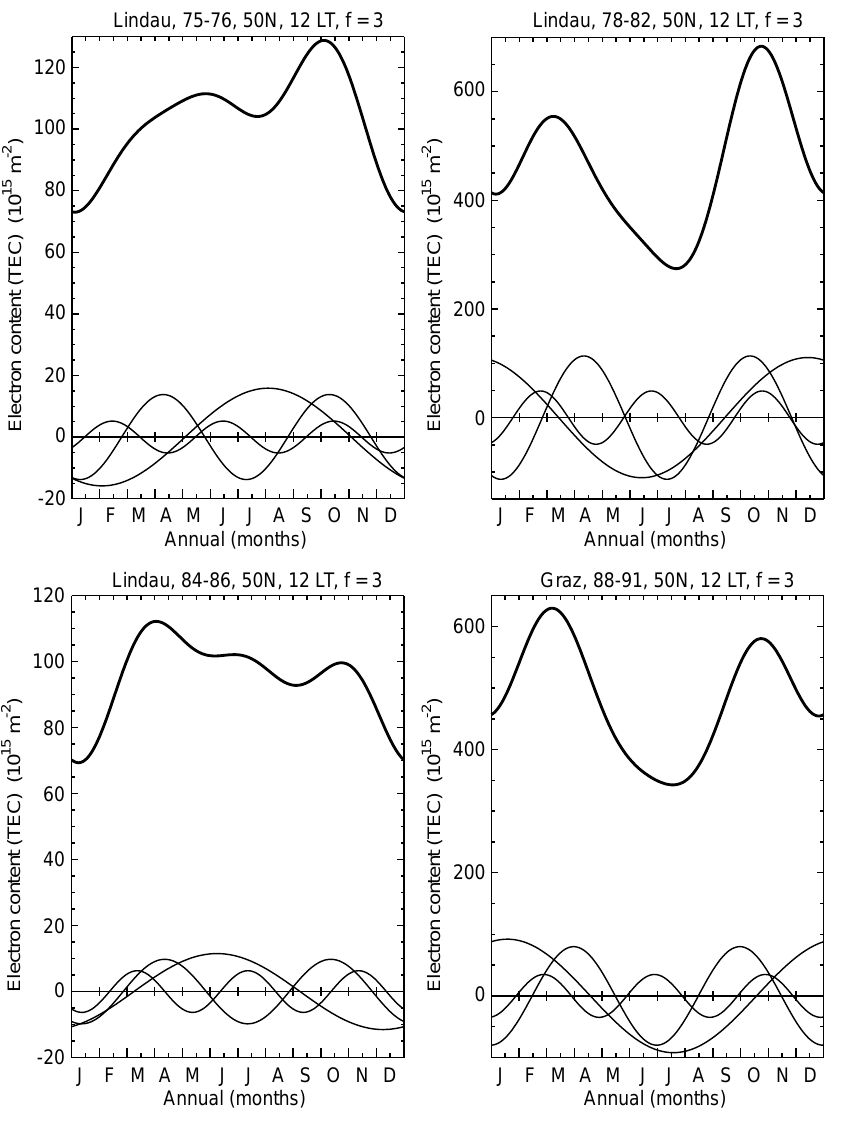
Fig. 3. Annual variation of ionospheric electron content (TEC) from four Fourier components (mean, 1-year, 1/2-year, 4-months). Low solar activity ( R (cid:136) 20) left-hand side , high solar activity ( R (cid:136) 150) right hand-side ; solar cycles 21 ( top ) and 22 ( bottom ). The 1 year, 1/2-year, 4-months components are shown separately ( thin lines ); based on bi-hourly monthly medians from months selected according to the solar